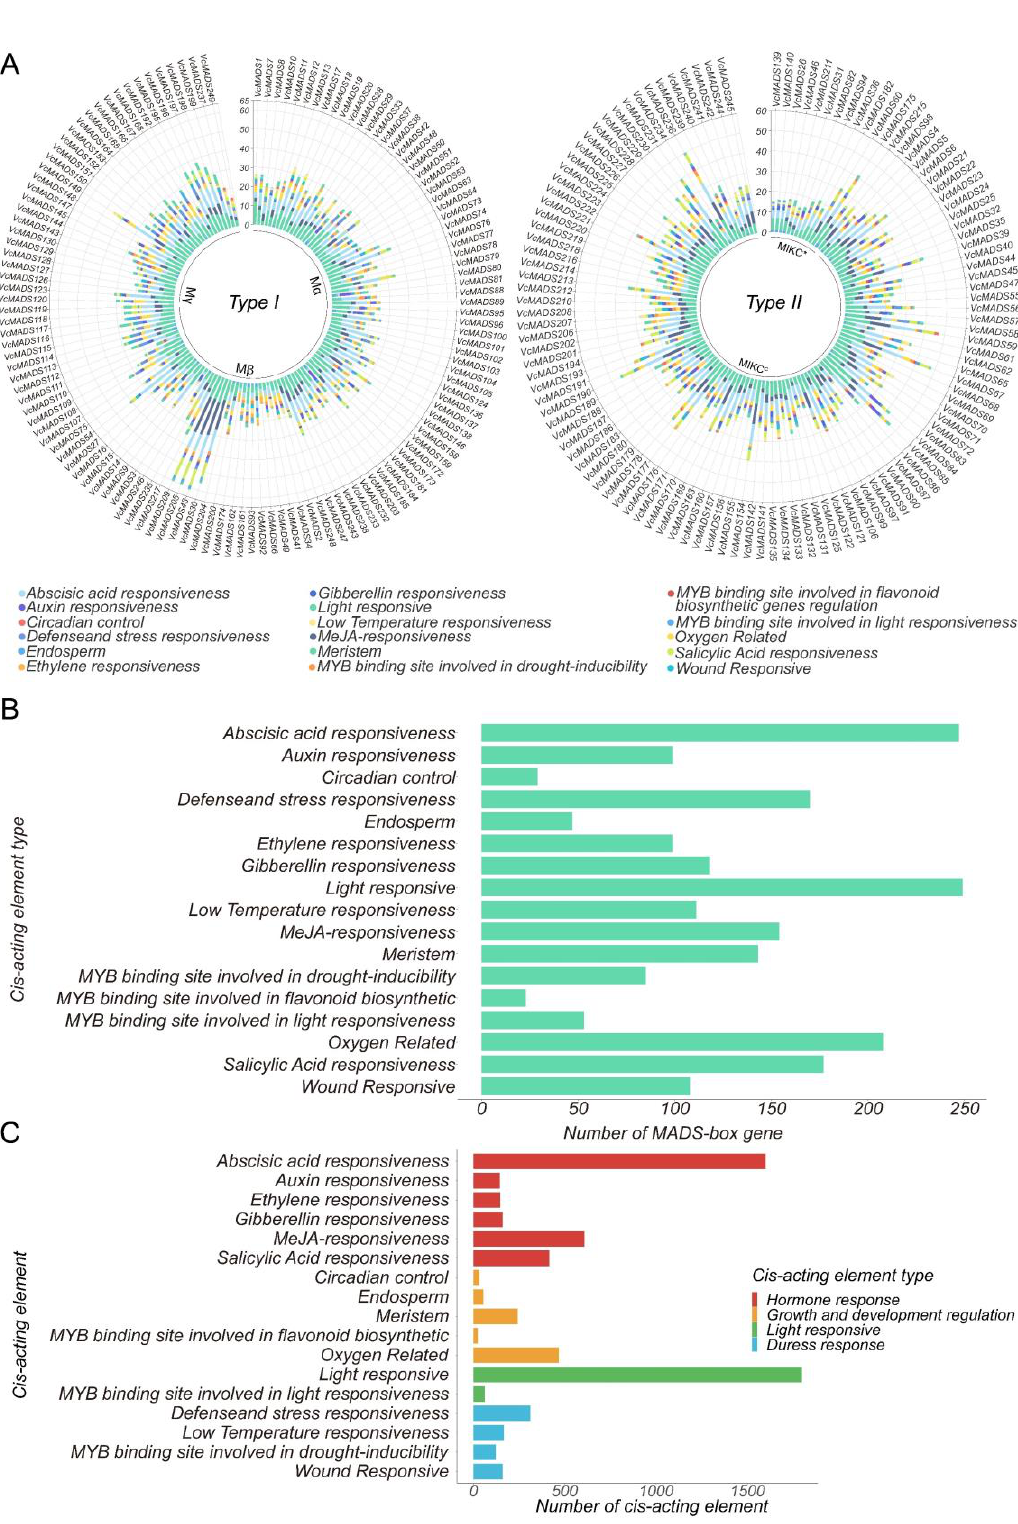
Figure 6. Cis-acting element prediction in blueberry MADS-box genes. ( A ) The number of cis-acting elements of type I and type II MADS-box genes. ( B ) The number of cis-acting elements distributed in MADS-box genes. ( C ) The total number of cis-acting elements, as well as the category.